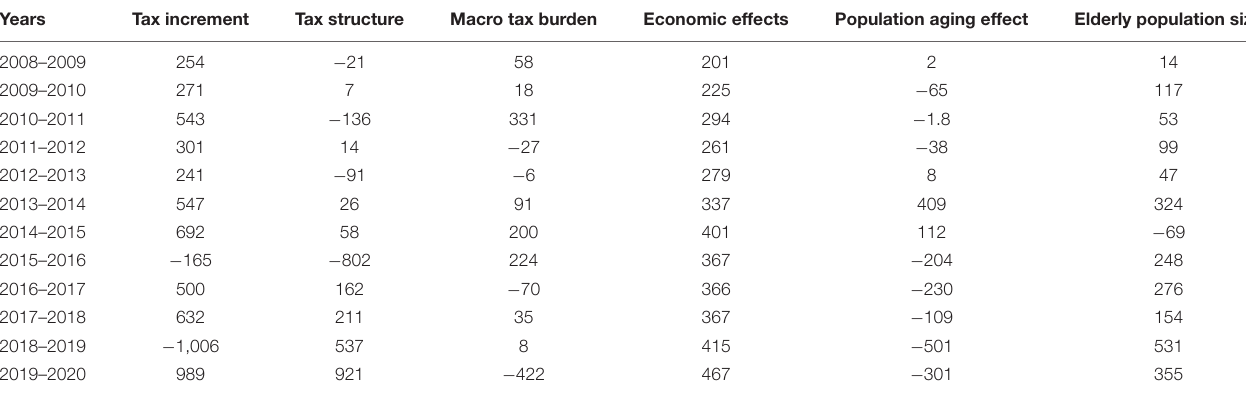
TABLE 1 | Decomposition results of national individual tax revenue